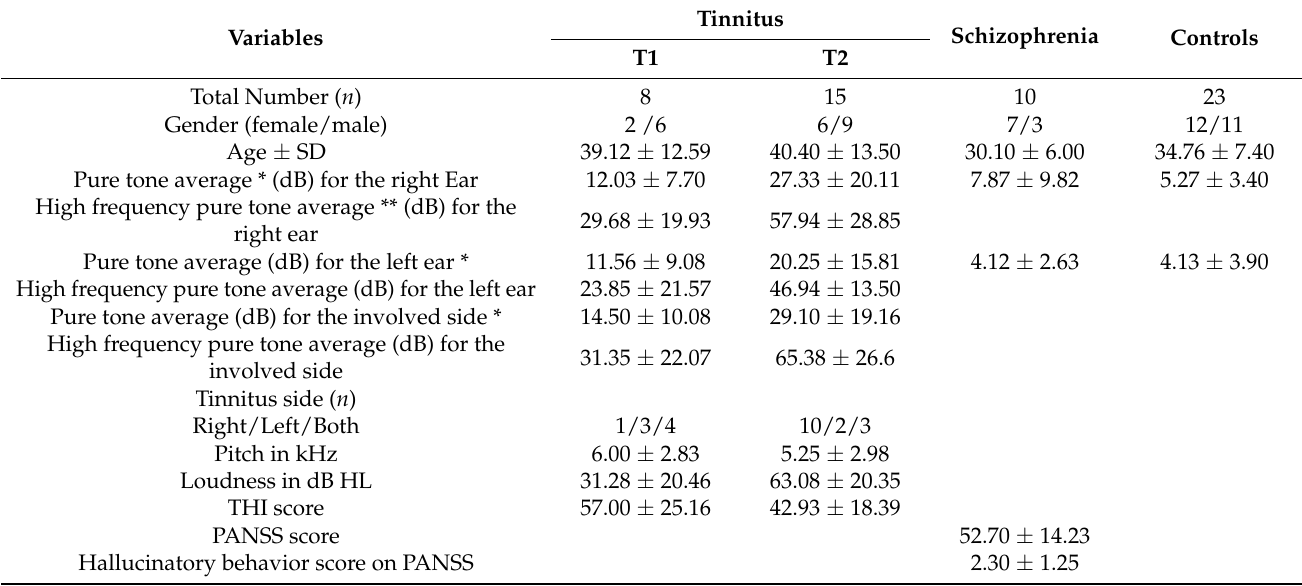
Table 1. Demographics of the study